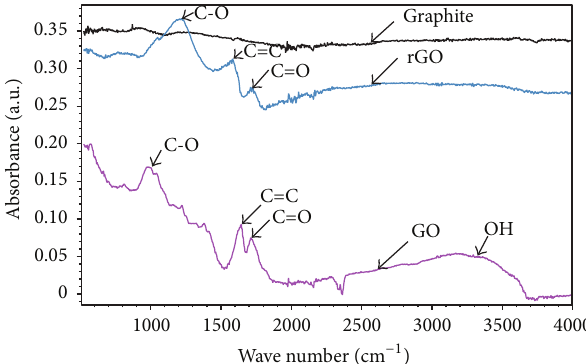
Figure 3: FTIR spectra of graphite (G), graphene oxide (GO), and reduced graphene oxide